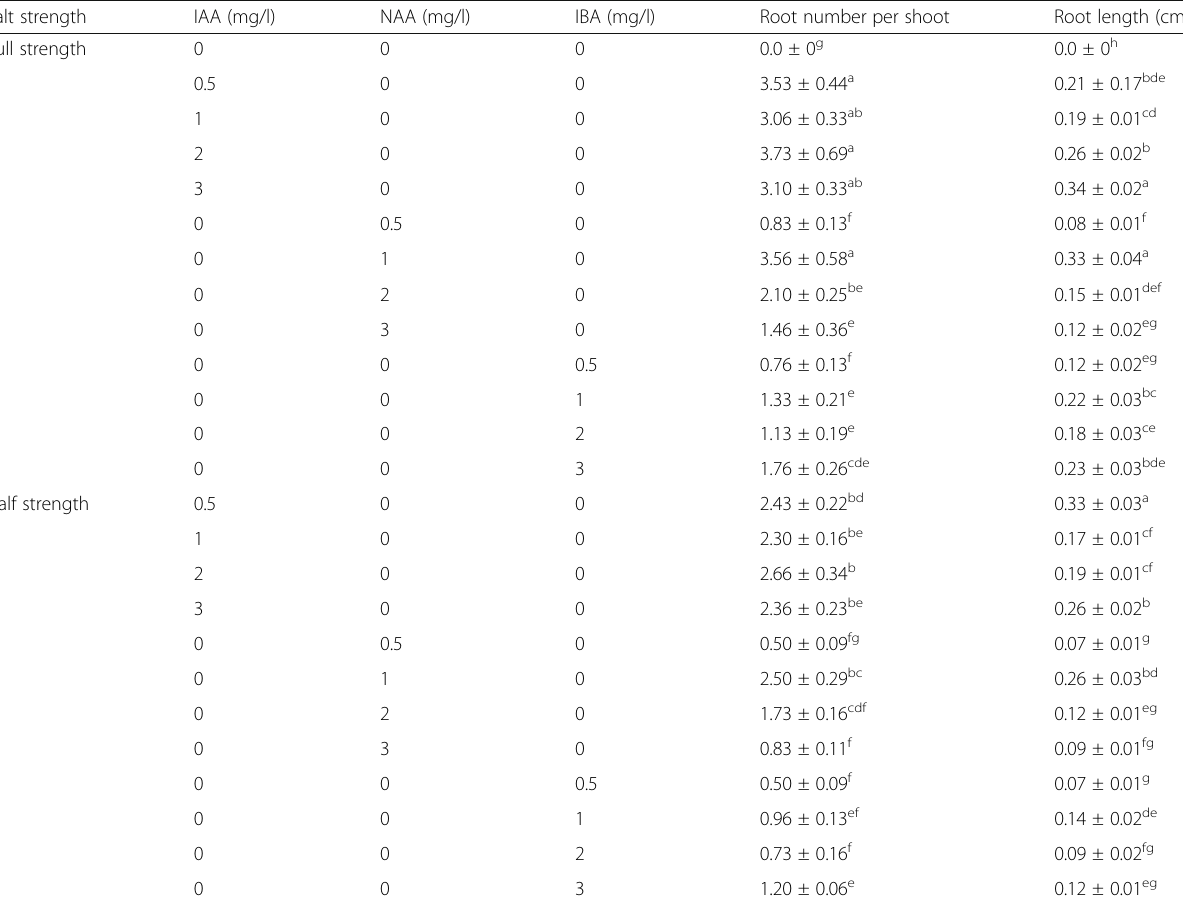
Table 7 Effect of MS salt strength and different auxin concentrations on number of roots per shoot and root length of S.